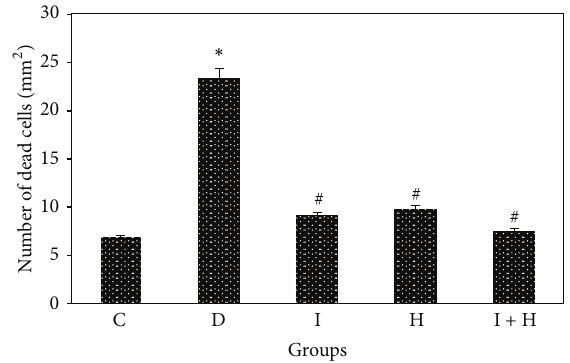
Figure 2: The effects of insulin and honey on neuronal cell death in the hippocampus of rats in each group (12 rats in each group). Bar graph indicates the mean ± SD ∗ 𝑃 < 0.0001 versus control group (C); # 𝑃 < 0.001 versus diabetic group